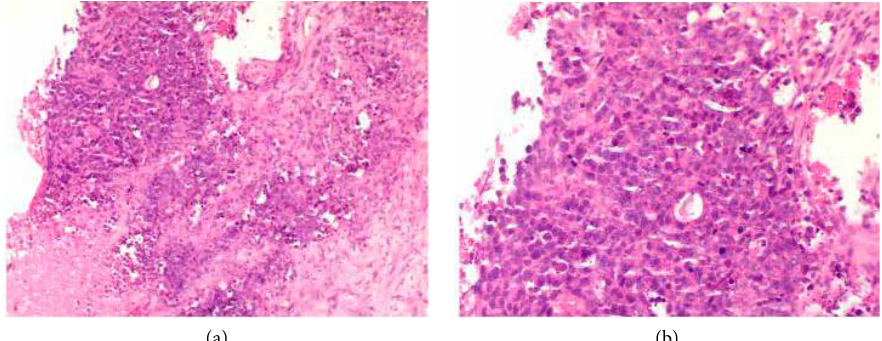
Figure 2: (a) H&E stained section of core biopsy of adrenal gland (×20 magnification). (b) H&E stained section of core biopsy of adrenal gland (×40 magnification). As this was a core biopsy, there was little tumour in p53 stained slide. No pole or MSI profiles were performed.